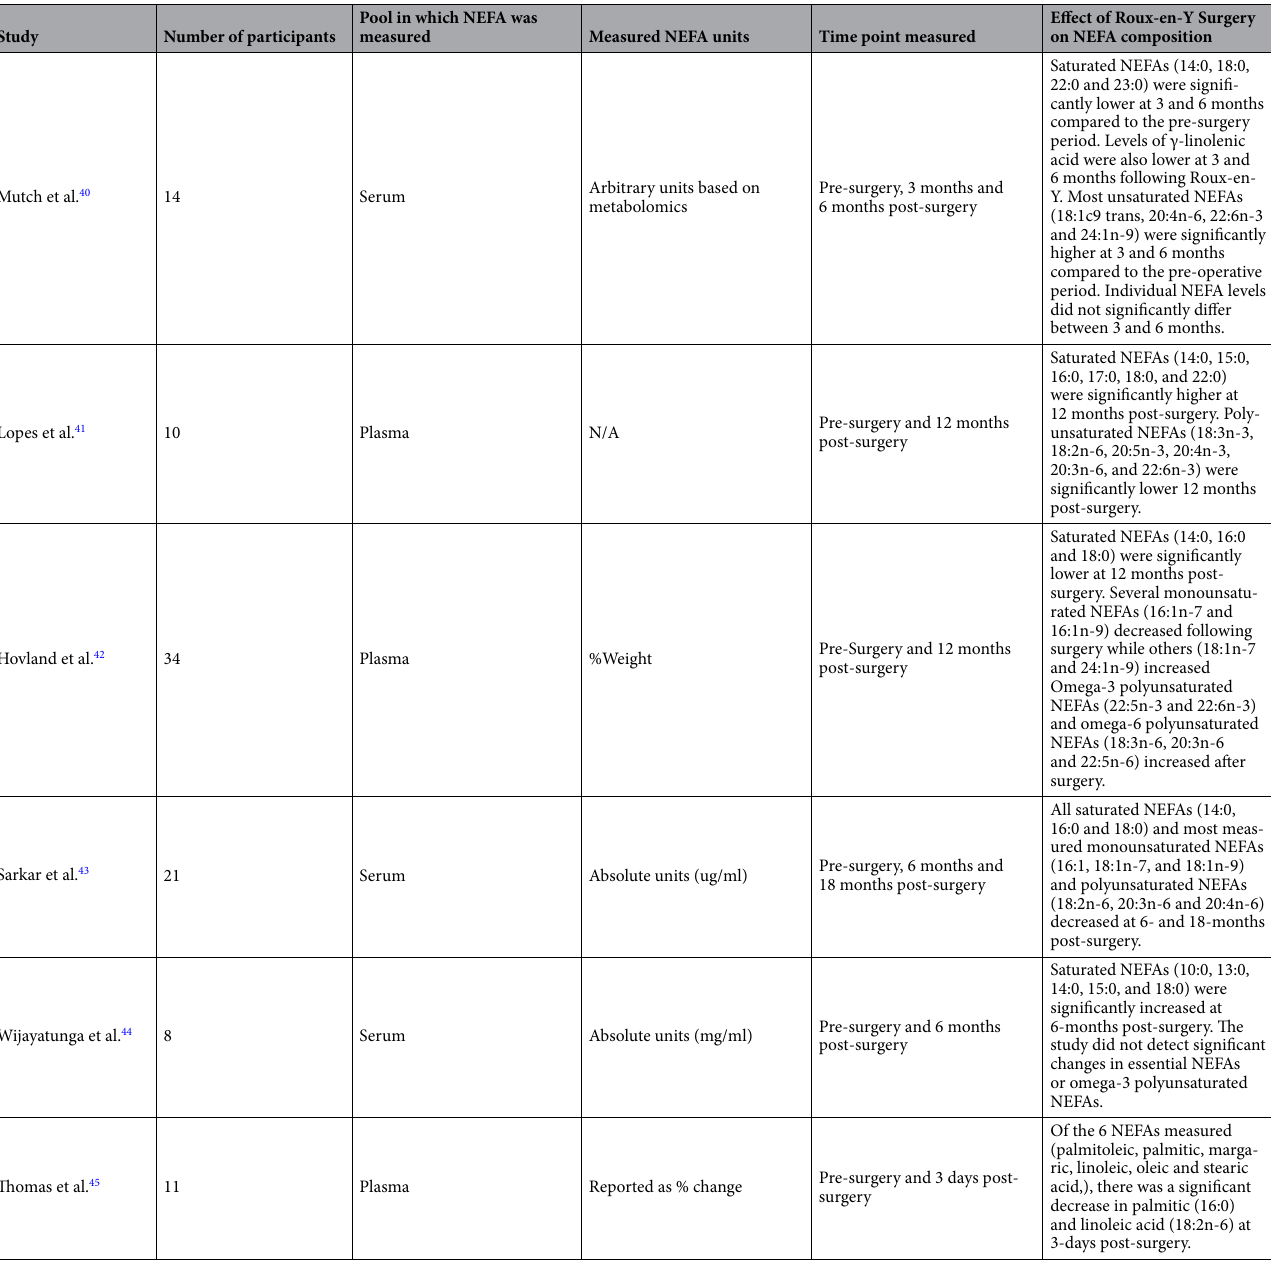
Table 4. Summary of previous studies investigating the effect of Roux-en-Y surgical intervention on plasma/ serum NEFA composition in obese patients at various time